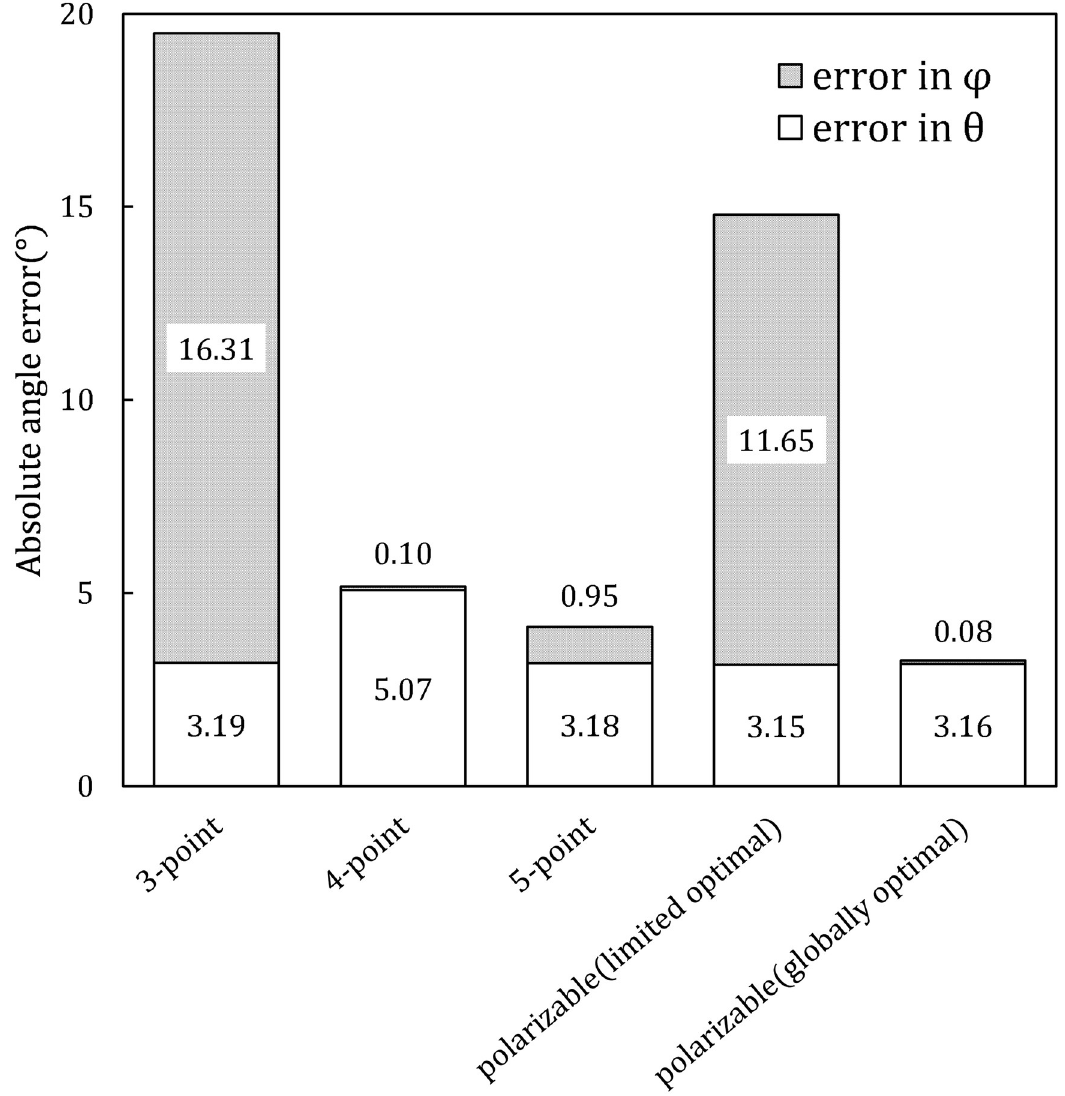
Fig 10. Absolute errors of the two key angles ( θ and φ , Fig 2) in a water dimer made of rigid or Drude polarizable model molecules. These errors are calculated with reference to the ab initio calculation values ( θ 0 = 57.9˚, φ 0 = 55.6˚) [38, 39]. Results of the 3, 4 and 5-point rigid water model dimers are built based on the “gas exp.” reference (Table 1), same with the polarizable